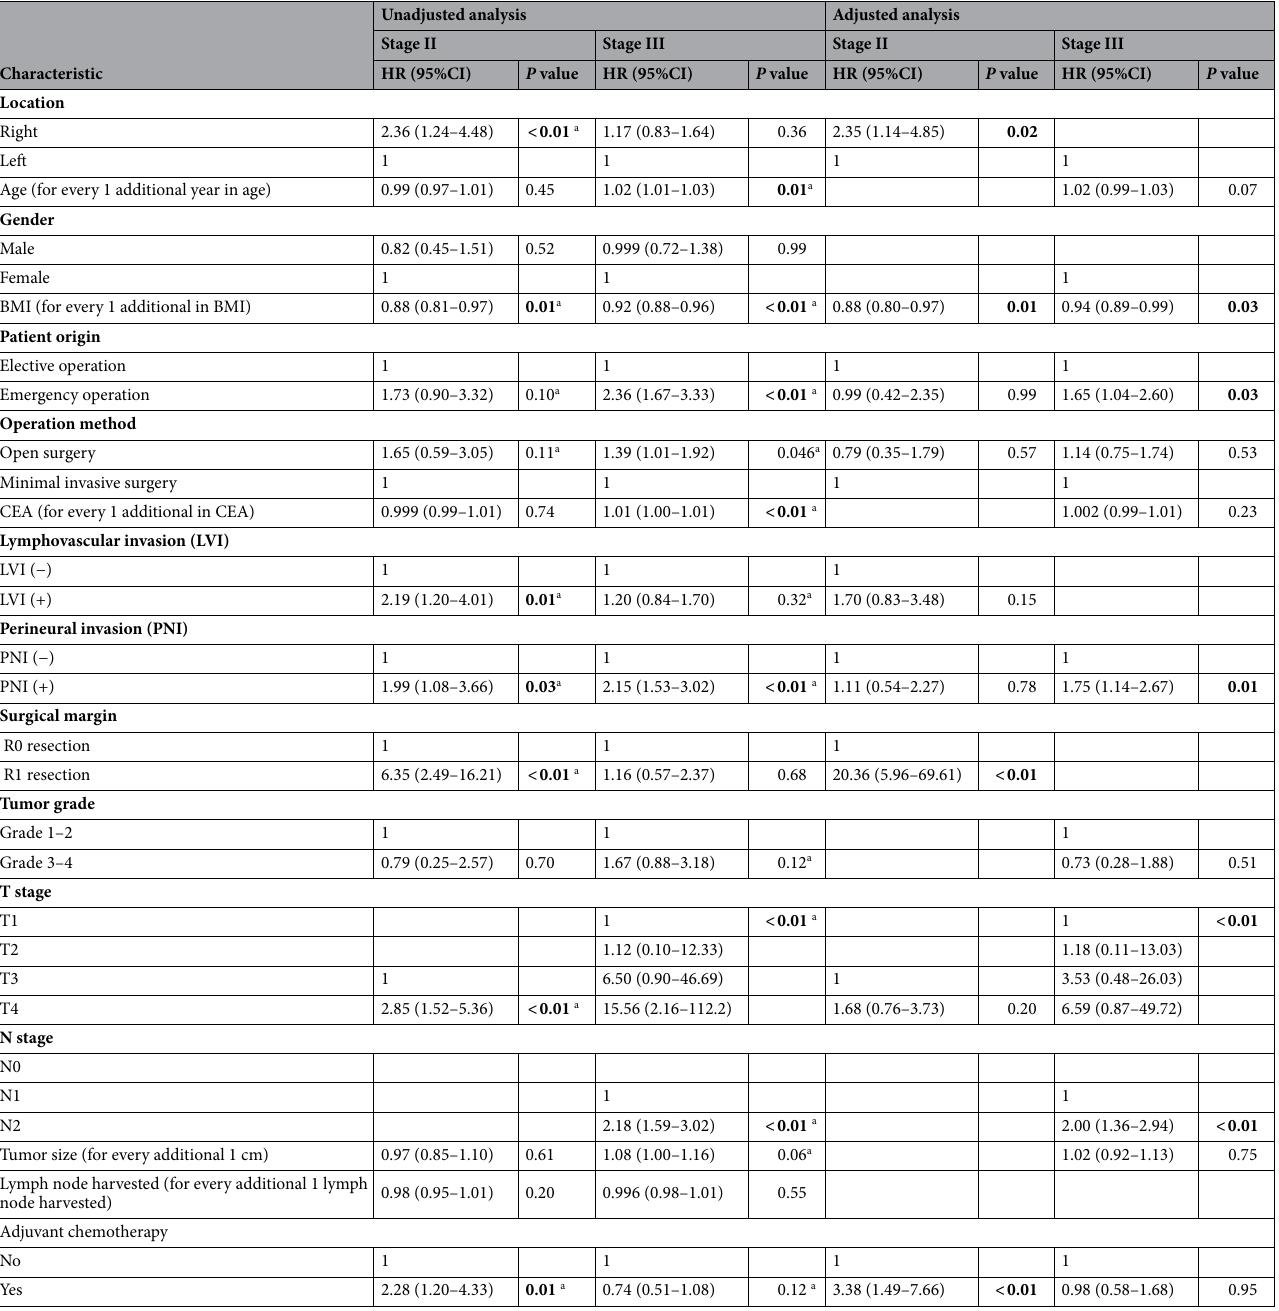
Table 3. Univariate and multivariate analysis a for TTR by Cox Proportional Hazards Regression in stage II and stage III colon cancer. Significant values are in bold. BMI Body mass index, CEA carcinoembryonic antigen. a Only variables with p < 0.2 in univariate analysis were included to multivariate